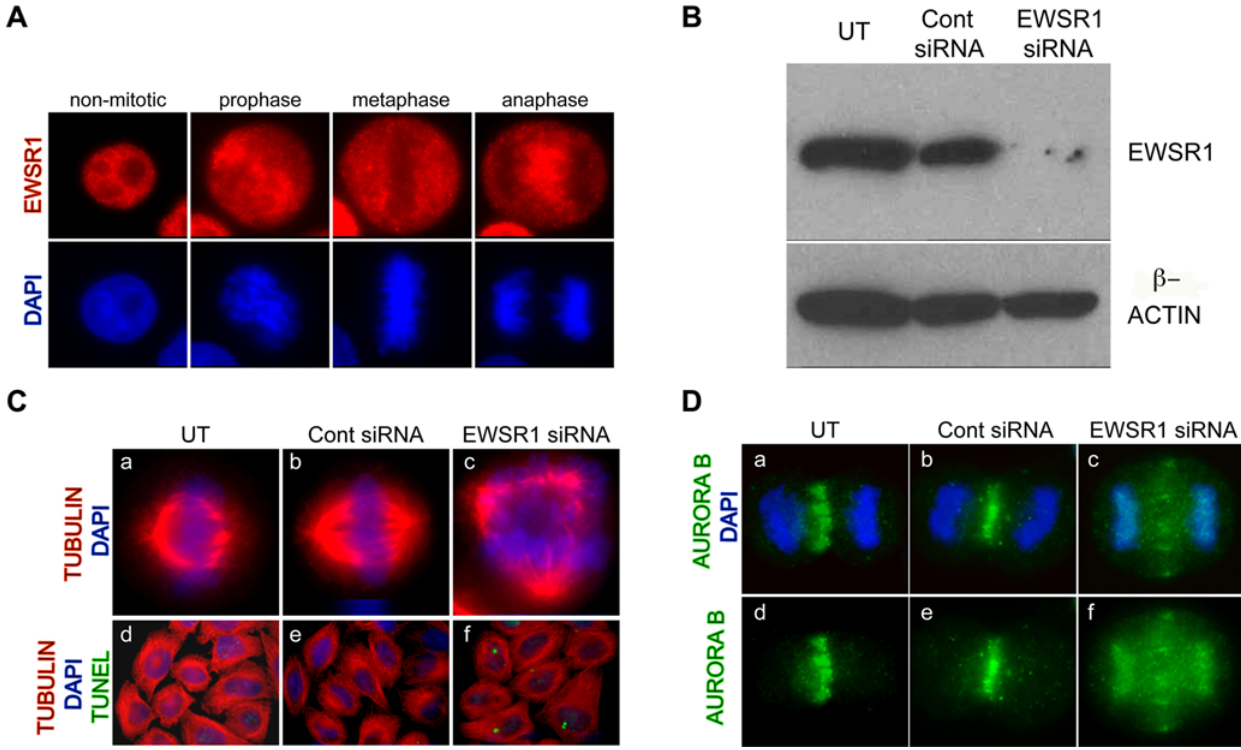
Figure 8. EWSR1 siRNA transfected Hela cells Display Mitotic Defects. A. EWSR1 localization in Hela cells during non-mitotic and mitotic-stages. EWSR1 was visualized by anti-EWSR1 antibody (red) and DNA was stained with DAPI (blue). B. EWSR1 protein (top panel) and b -Actin (bottom panel) visualized by western blotting. C. Representative images of mitotic spindles from (a and d) UT, (b and e) Cont siRNA and (c and f) EWSR1 siRNA transfected Hela cells. DNA was stained with DAPI (blue), the spindles were visualized by a -Tubulin (red) and the apoptotic cells were visualized by TUNEL assay (green). D. Representative images of Aurora B (green) with DNA (blue) (a–c), and Aurora B (green) without DNA (d–f). (a and d) UT, (b and e) Cont siRNA and (c and f) EWSR1 siRNA transfected Hela cells. UT: untransfected, Cont siRNA: control siRNA transfected, EWSR1 siRNA: EWSR1 siRNA transfected Hela cells.